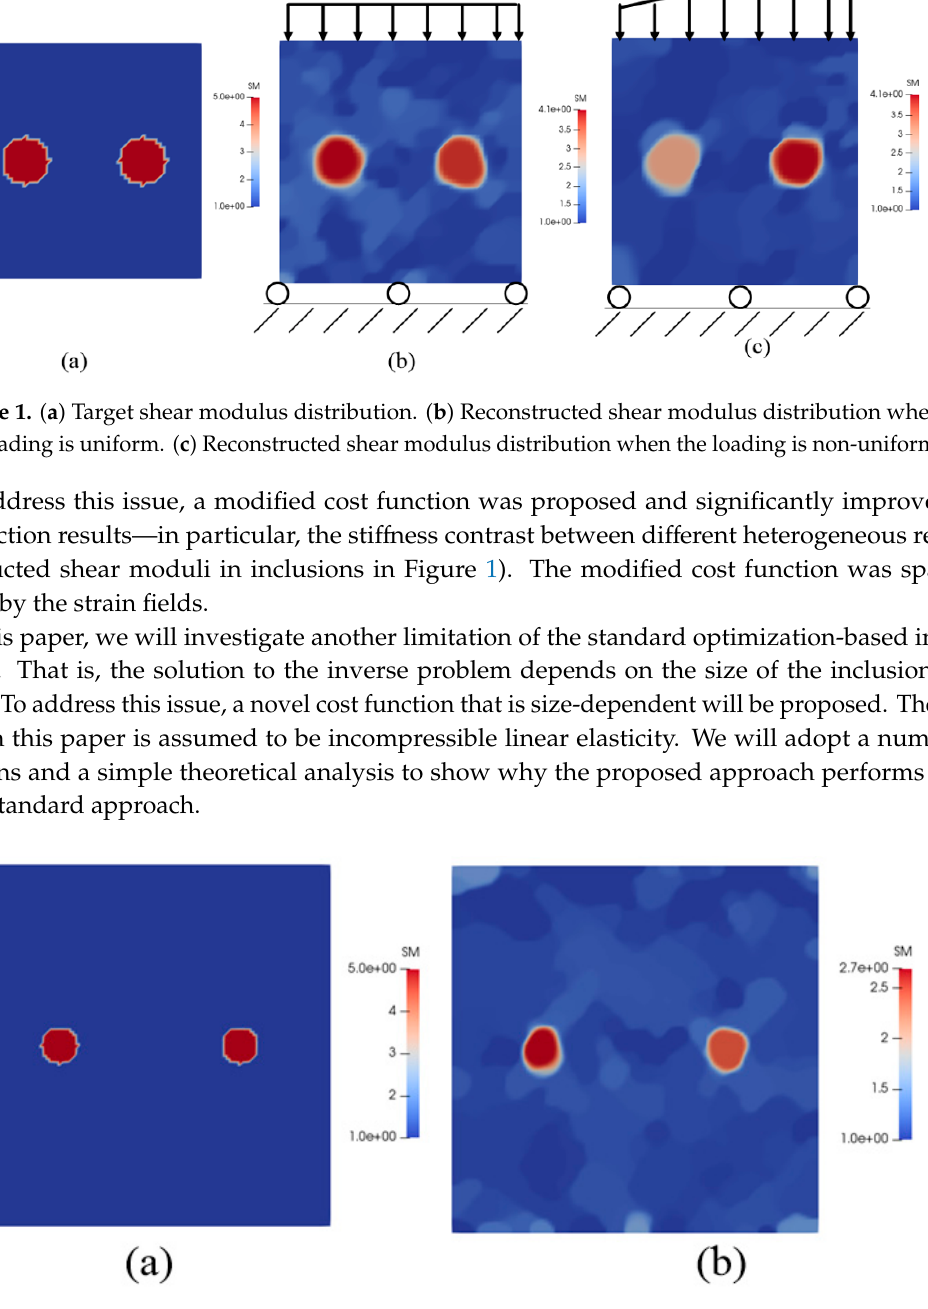
Figure 2. ( a ) Target shear modulus distribution where two inclusions are of the same size. ( b ) Reconstructed shear modulus distribution with a regularization factor of 3.0 × 10 − 10